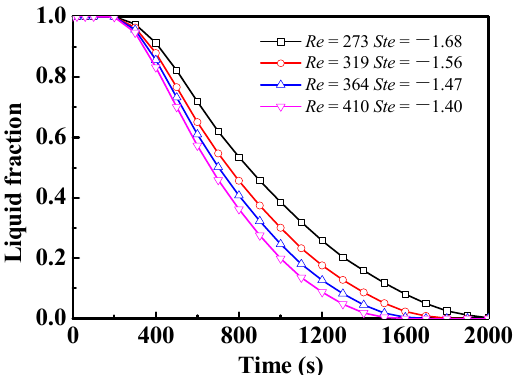
Figure 12. Time evolution of liquid fractions at different inlet velocity ( Re )/inlet temperature ( Ste ) ( Re / Ste ) numbers under the given inlet power condition.